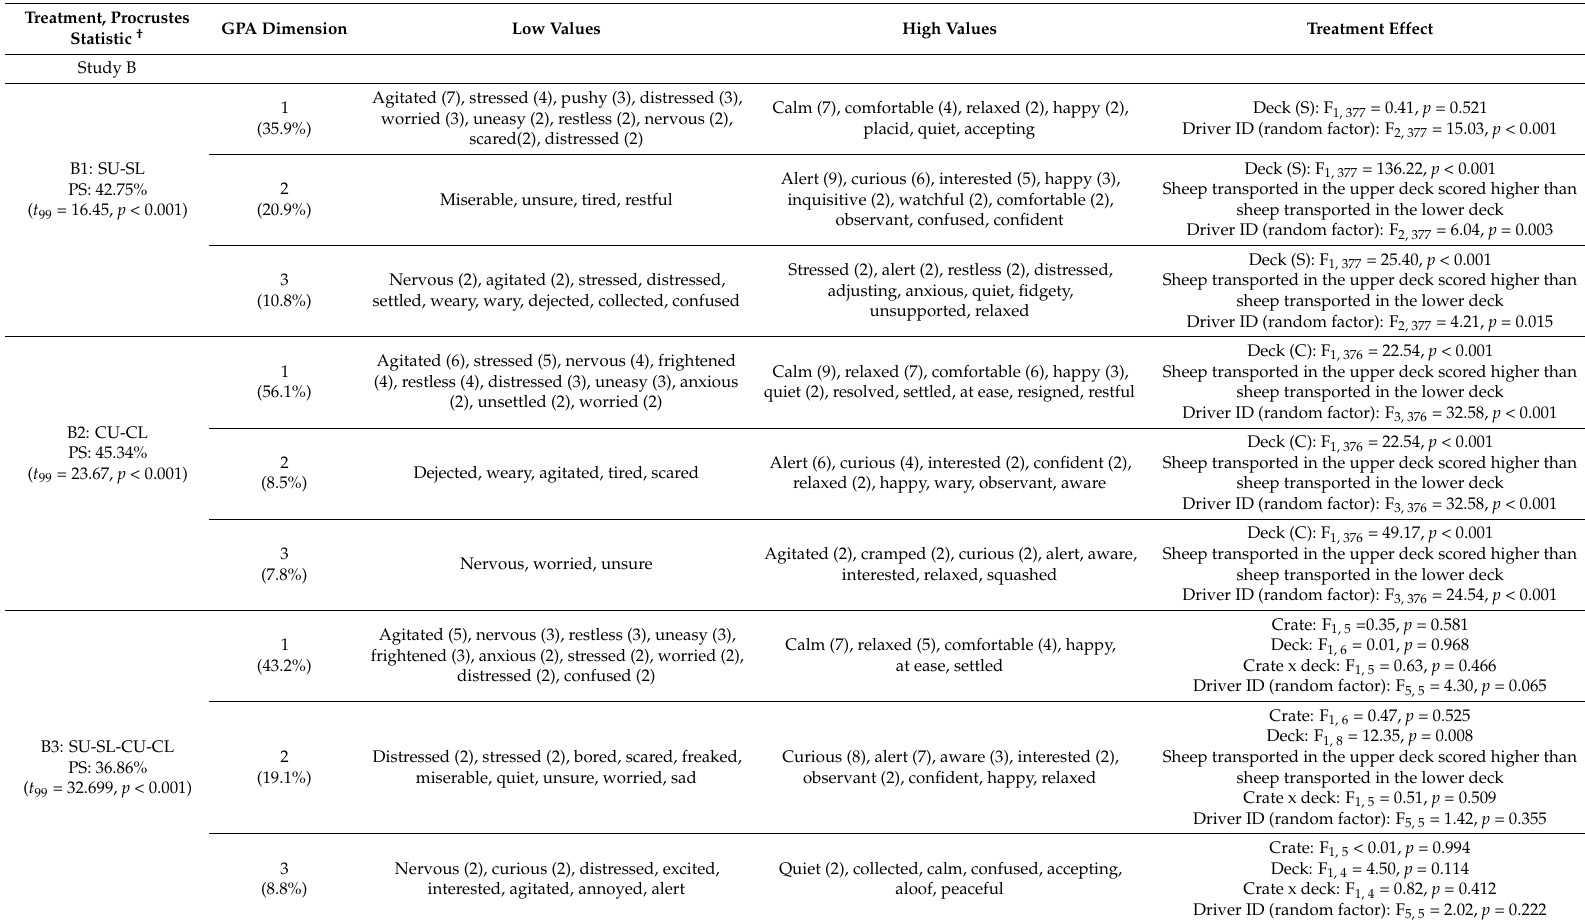
† PS: Procrustes Statistic showing the percentage of variance in the dataset that could be attributed to the consensus in scoring between individual observers and the results for the one-way t -test comparing this result with a mean randomised profile of the same dataset, indicating that the consensus between observers in their use of descriptive terms to quantify the behavioural expression of these sheep was statistically